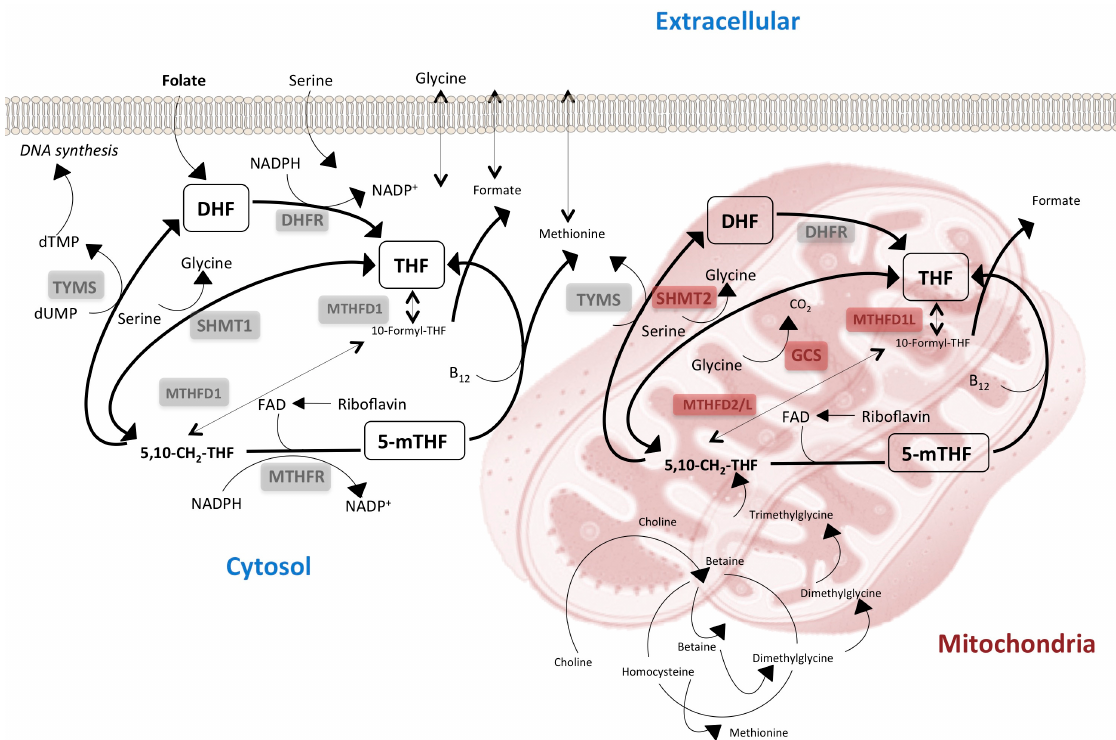
Figure 4. Mitochondrial and cytosolic pathways for generating and processing 1C units are separated but not redundant and depend on extracellular provision. Metabolically active cells may survive deficiencies in cytosolic isozymes but require the correct function of mitochondrial isozymes (marked in red). GCS, glycine cleavage system.